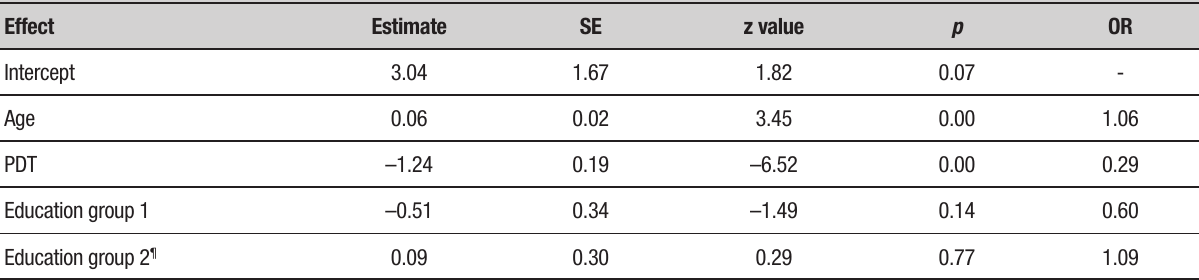
B. Estimates of logistic regression model with diagnosis of AD as the dependent variable and age, PDT and education as independent